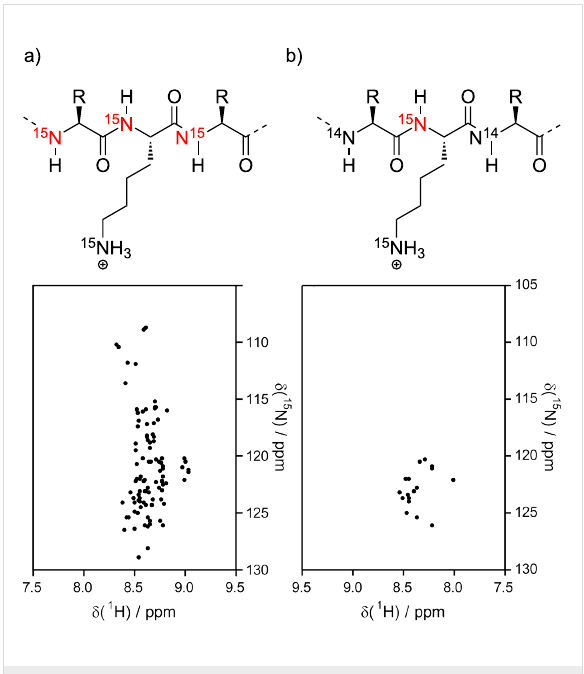
Figure 5: Schematic 1 H, 15 N-HSQC spectrum of tauF4 (chemical shifts from BMRB # 17945, [109]) with and without specific 15